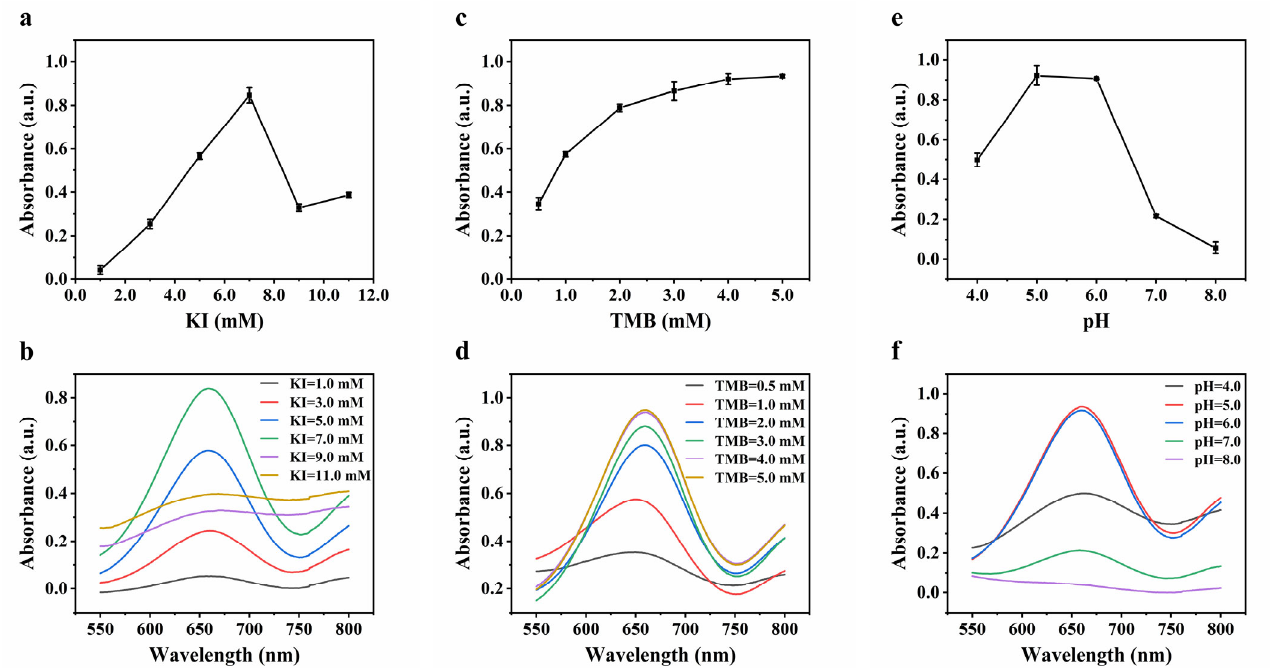
Figure 3. Effects of KI concentration ( a ), TMB concentration ( c ), and buffer pH ( e ) on the absorption at 652 nm of KI ‐ TMB system for the detection of H 2 O 2 . UV–Vis spectra of the reaction system containing different concentrations of KI ( b ), TMB ( d ) and different pH ( f ).